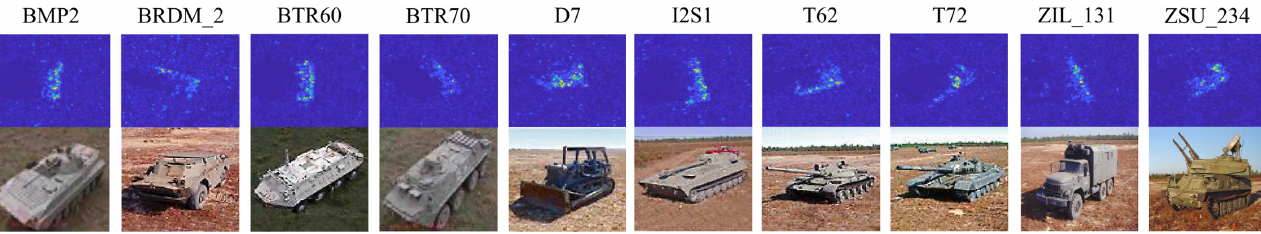
Figure 2. Optical and SAR pictures of ten target types from the MSTAR collection. The image’s relevant targets are BMP2, BRDM 2, BTR60, BTR70, D7, I2S1, T62, T72, ZIL 131, and